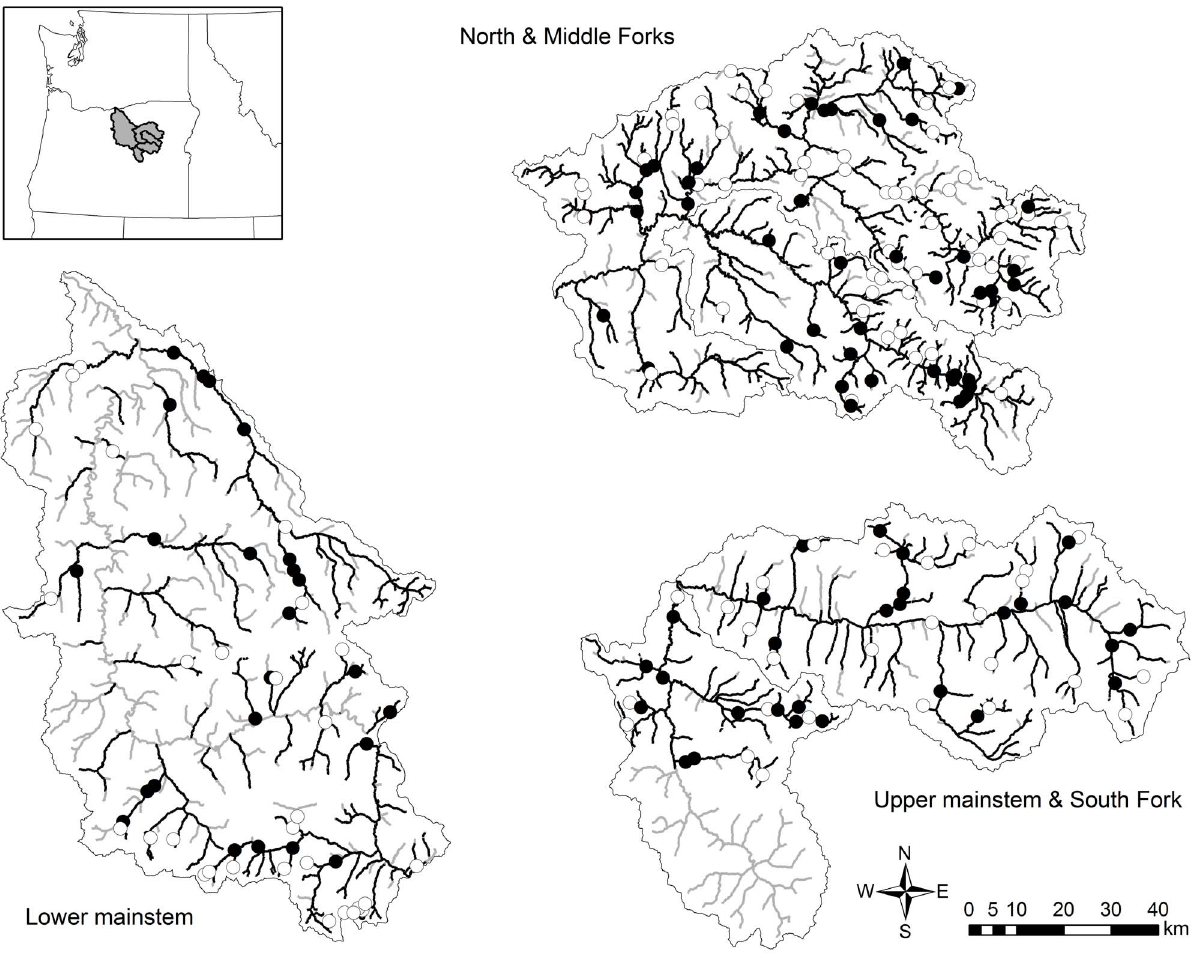
Figure 1. Map of the study area in the John Day River basin, Oregon, USA. Locations of 209 steelhead redd surveys conducted within five catchments (inset) from 2004–2010 are shown (circles). Filled circles are sites where redds were observed; redds were not observed at sites represented by an open circle. Bold stream lines indicate stream reaches that potentially support spawning and early rearing of steelhead (Oregon Department of Fish and Wildlife, unpublished data